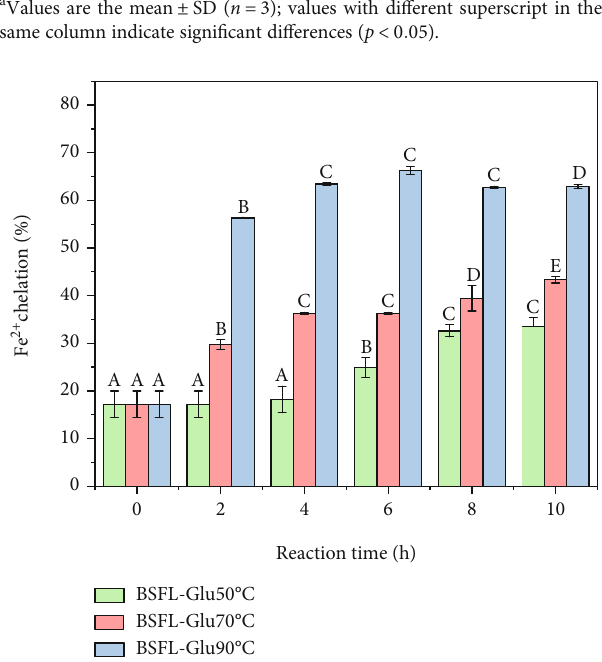
Figure 5: Iron chelating activity of BSFL-Glu conjugates as a function of reaction time. Values are mean ± standard deviation ; means with di ff erent superscript are signi fi cantly di ff erent at the same heating temperature.